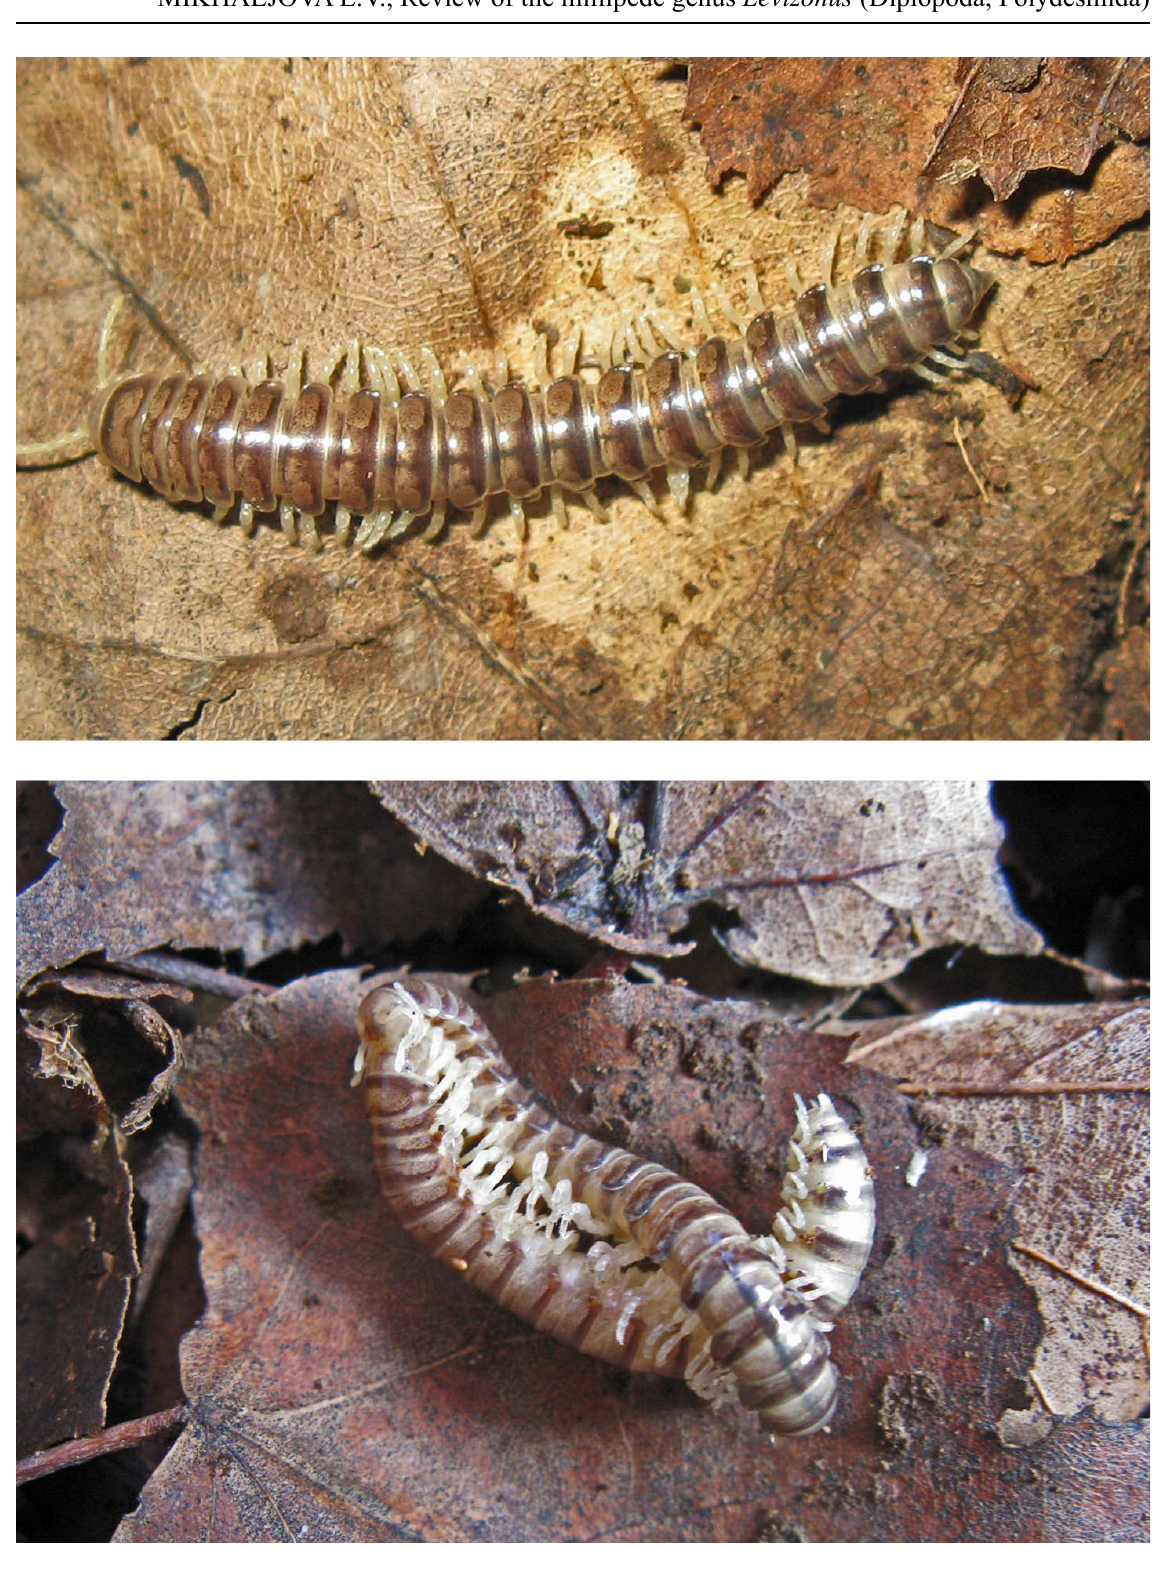
Fig. 12. Levizonus thaumasius Attems, 1898, ♂ and ♀. A . Habitus, dorsal view. B . Copulation. Photographed not to scale. Photo by the